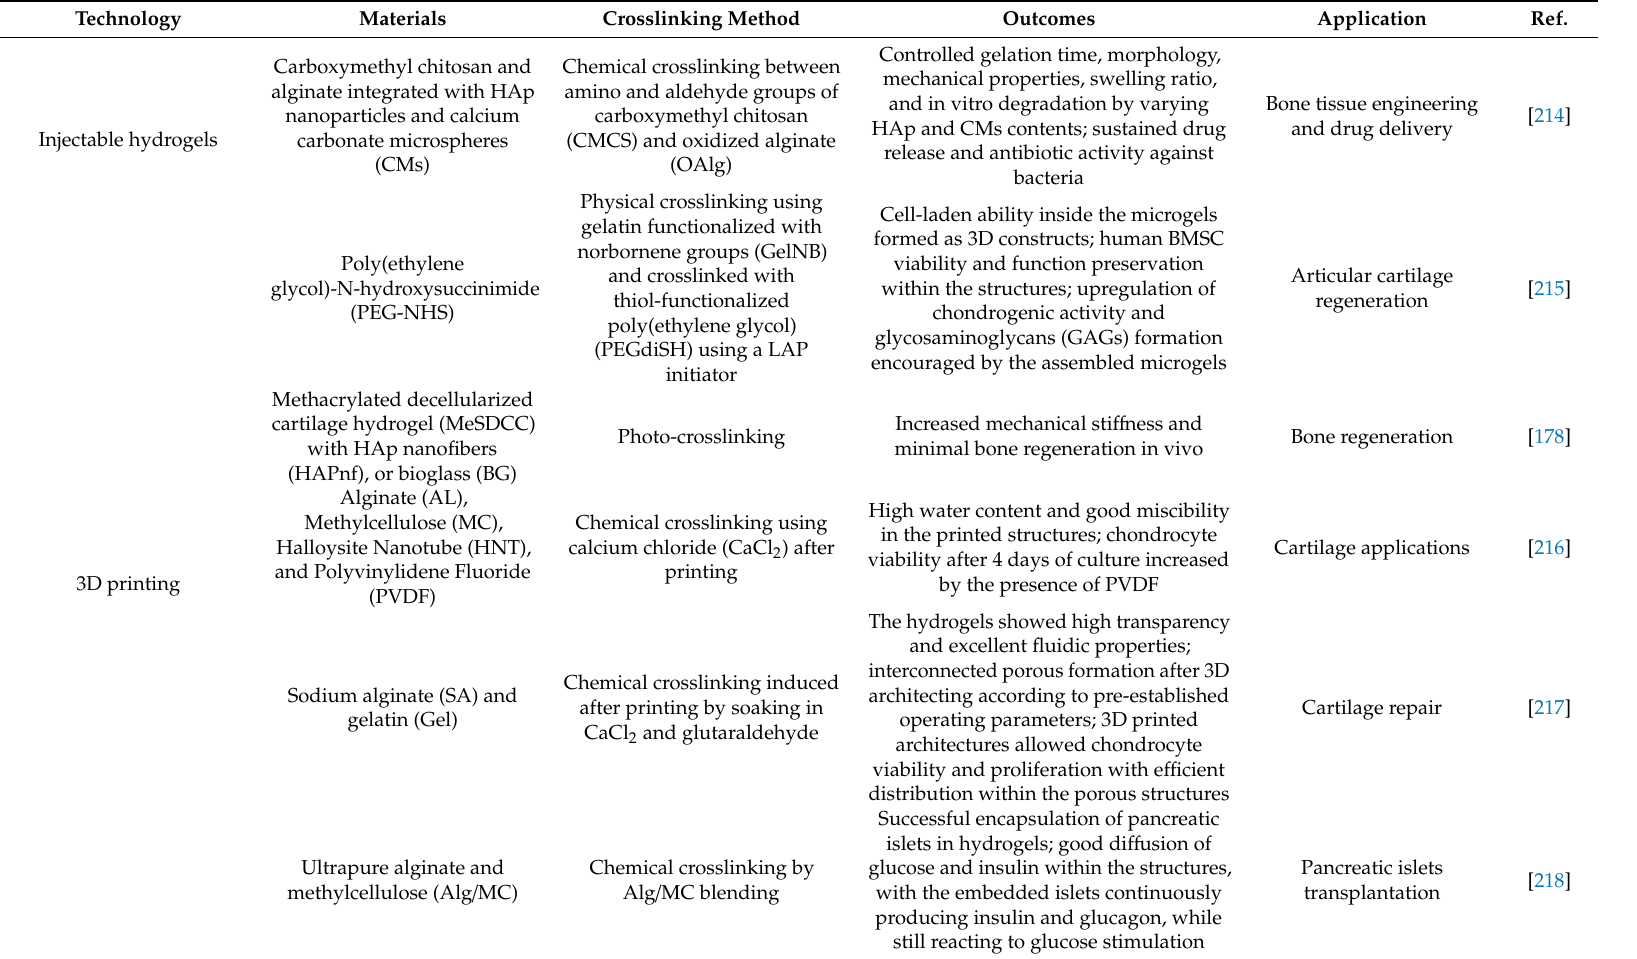
Table 2. Technologies and crosslinking methods for producing innovative hydrogel-based matrices for TE